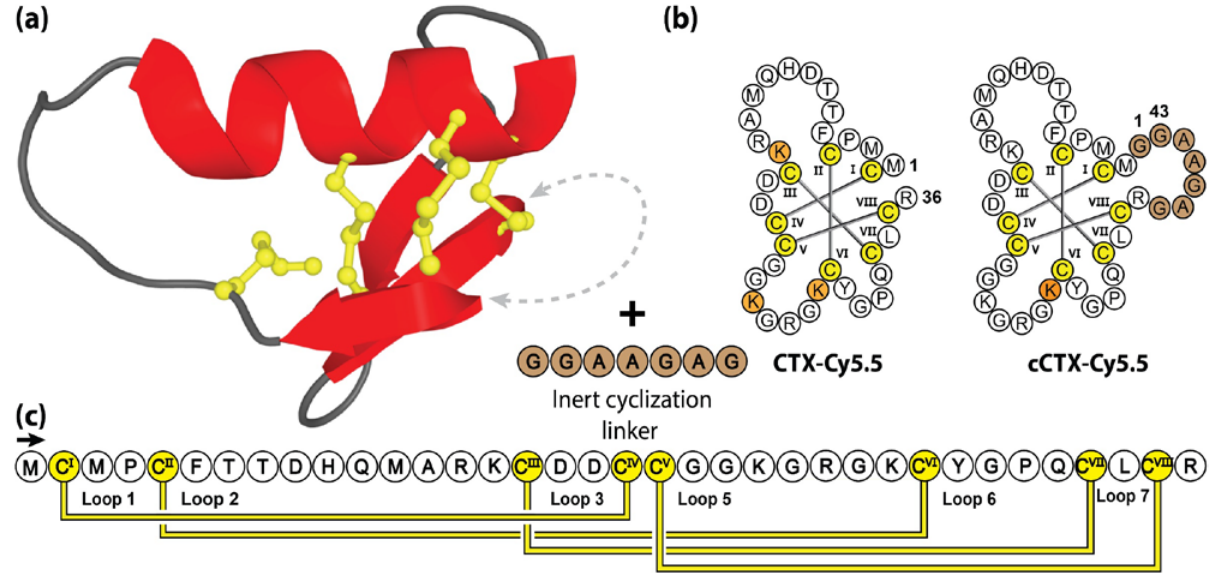
Figure 8. Structure and sequence of CTX and its cyclic analogue. ( a ) Three-dimensional structure of CTX, with engineered cyclization linker. ( b ) Peptide sequences of CTX and its engineered cyclic variant cCTX. ( c ) Amino acid sequence, disulfide bond connectivity and loop nomenclature of CTX. Cysteine residues are numbered and highlighted in yellow, with non-native residues and sites of lysine Cy5.5 conjugation indicated by brown and orange shading, respectively.